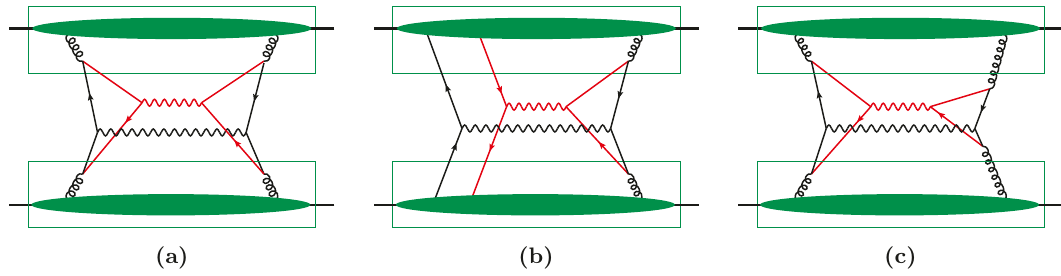
Figure 4. Graphs that contribute to several terms in the cross section (5.30). The rectangular boxes and oval blobs indicate the relevant hadronic matrix elements, depending on whether the g q ¯ q splittings are collinear or hard. →